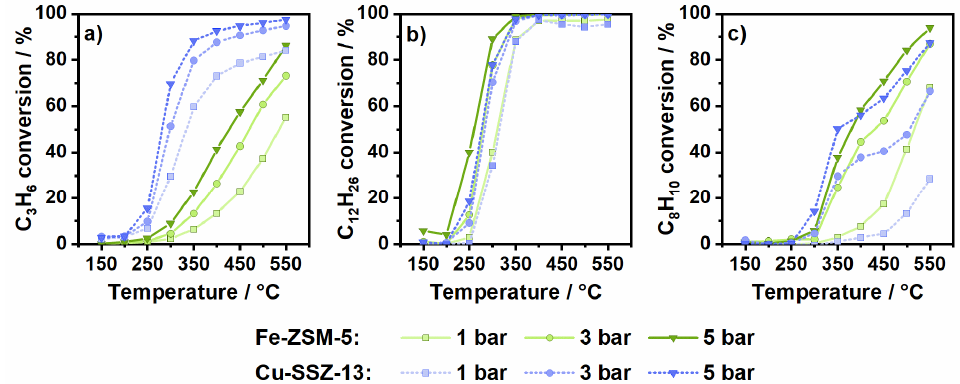
Figure 1. Hydrocarbon conversion by oxidation of ( a ) 200 ppm C 3 H 6 , ( b ) 50 ppm C 12 H 26 and ( c ) 75 ppm C 8 H 10 (14% O 2 , 4.5% H 2 O in N 2 ) over Fe-ZSM-5 and Cu-SSZ-13 at 1, 3 and 5 bar pressure.